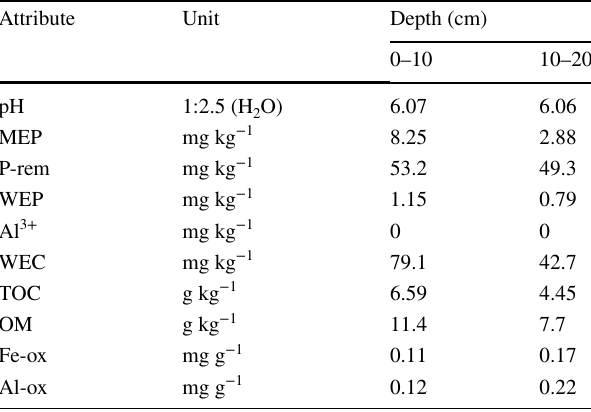
Table 2 Chemical analysis of Dystric Xeropsamments with long-term organic fertilization